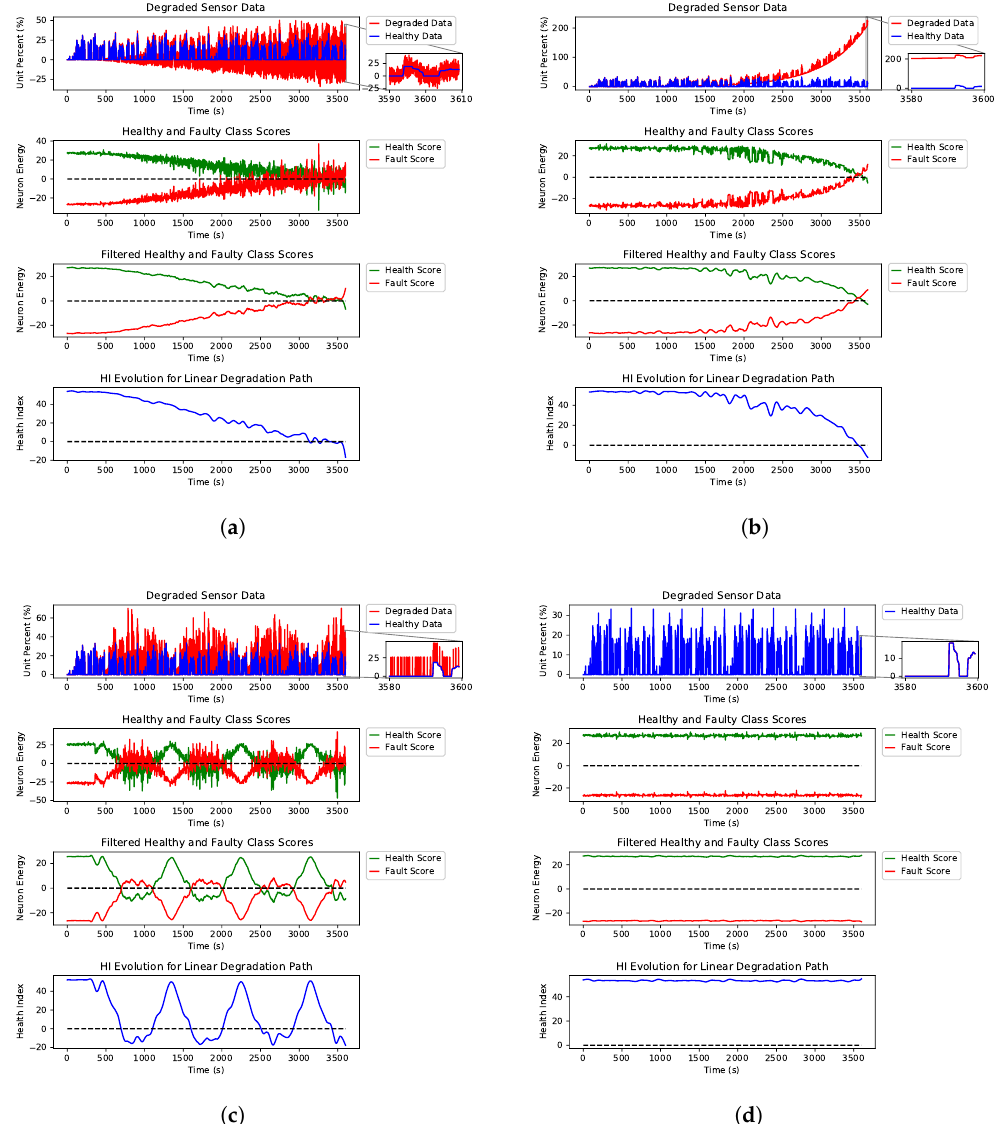
Figure 7. Three different degradation scenarios for erratic, drift and spike fault types of the AccP sensor. ( a ) Steps taken to construct the HI from a linearly degraded AccP data stream with erratic fault. ( b ) Steps taken to construct the HI from an exponentially degraded AccP data stream with drift fault. ( c ) Steps taken to construct the HI from a sinusoidal degraded AccP data stream with spike fault. ( d ) Steps taken to construct the HI from a healthy AccP data